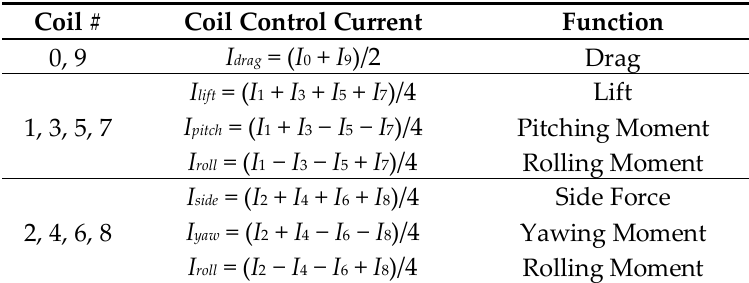
Table 1. Function of coils in 1-m